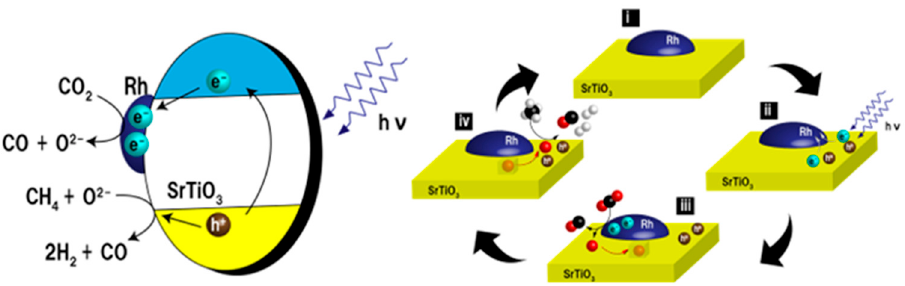
Figure 36. Speculated mechanism of photocatalytic DRM using Rh/SrTiO 3 . Reprinted from [30].